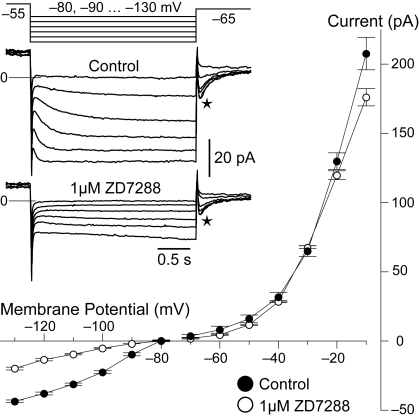
The Ih blocker ZD7288 has high affinity and specificity for the hyperpolarization–activated current.Perfusion of the organic drug abolished almost entirely the putative Ih current already at a concentration of 1 µM (inset traces, averages of 4, were obtained with the voltage–clamp protocol of hyperpolarizing steps shown at the top). The specificity of its action can be appreciated on the I–V plot, which shows current amplitudes measured at the end of the voltage steps of two different protocols (see also Results and Figure 1), one targeted for inward currents (hyperpolarizing steps) and the other for outward currents (depolarizing steps). After about 25 min (empty circles) ZD7288 strongly reduced the currents activated below −80 mV, compared to control conditions (full circles). The residual current includes an ohmic leakage. Plot displays means and standard errors.